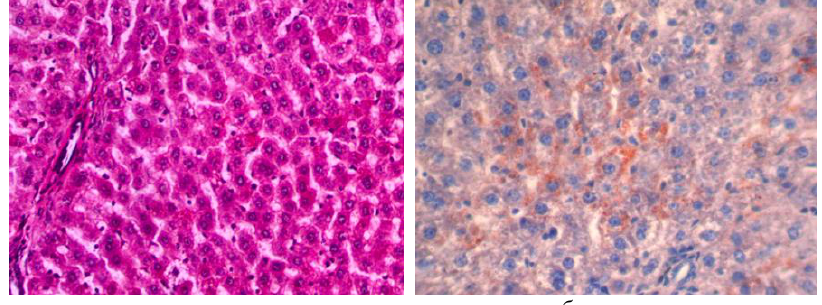
Рис. 4. Печінка щурів після введення антидіабетичного збору у дозі 9 мл/кг: а – відновлення вмісту гранул глікогену